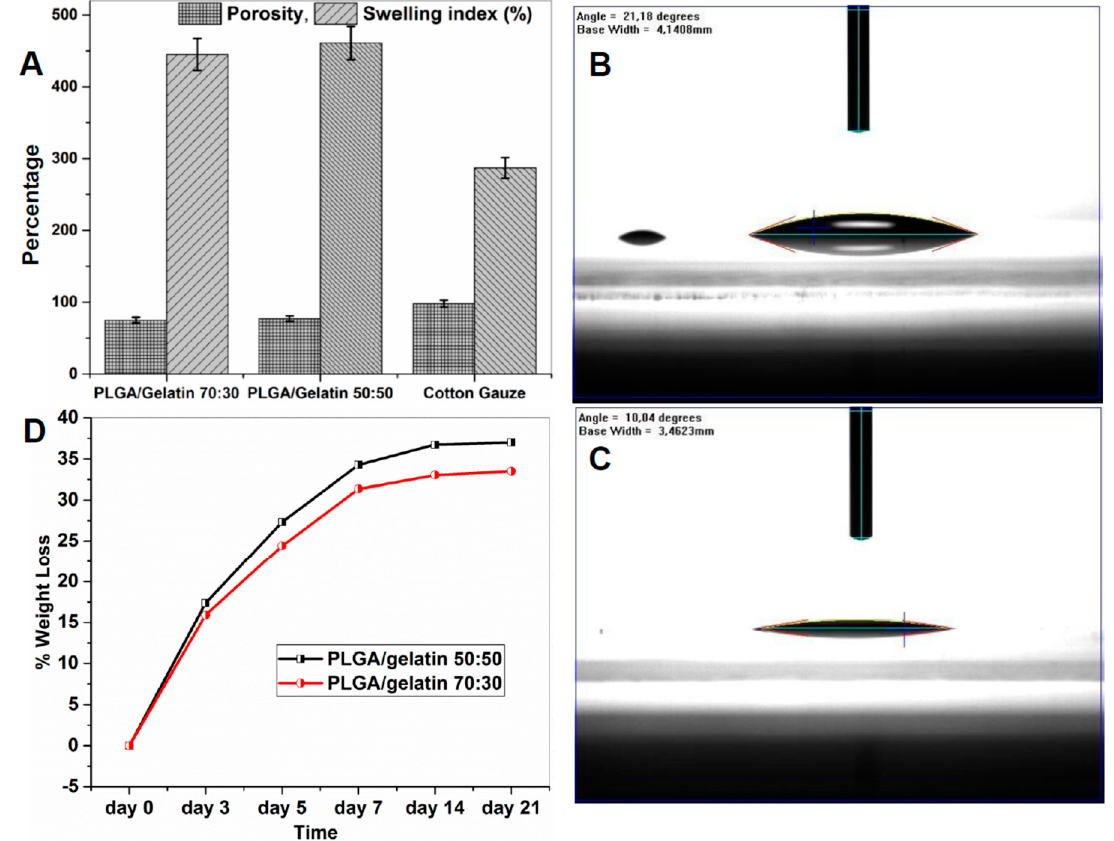
Figure 4. Scaffold stability and wettability analysis. ( A ) Comparison of swelling index and porosities of electrospun PLGA/gelatin 70:30 and 50:50 nanofibrous scaffolds (the results are expressed as the median ± standard deviation from five samples). ( B ) Water Contact Angle Value for PLGA/Gelatin 50:50 Nanofibrous Scaffold. ( C )Water Contact Angle Value for PLGA/Gelatin 70:30 Nanofibrous Scaffold. ( D ) Biodegradability characteristics of PLGA/gelatin 50:50 and PLGA/gelatin 70:30 nanofibrous scaffolds.